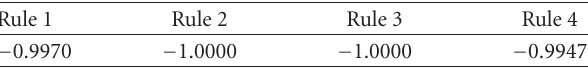
Table 9: Estimated lambda ( λ m ).